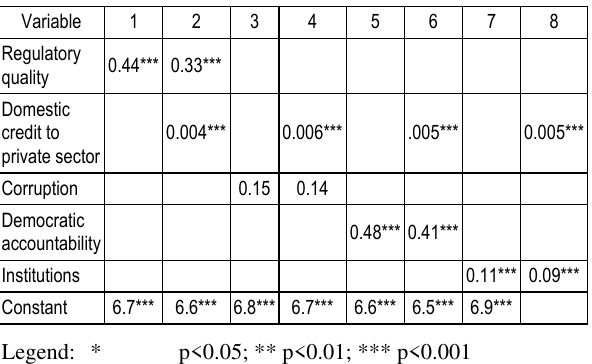
Table 2. Growth and institutional